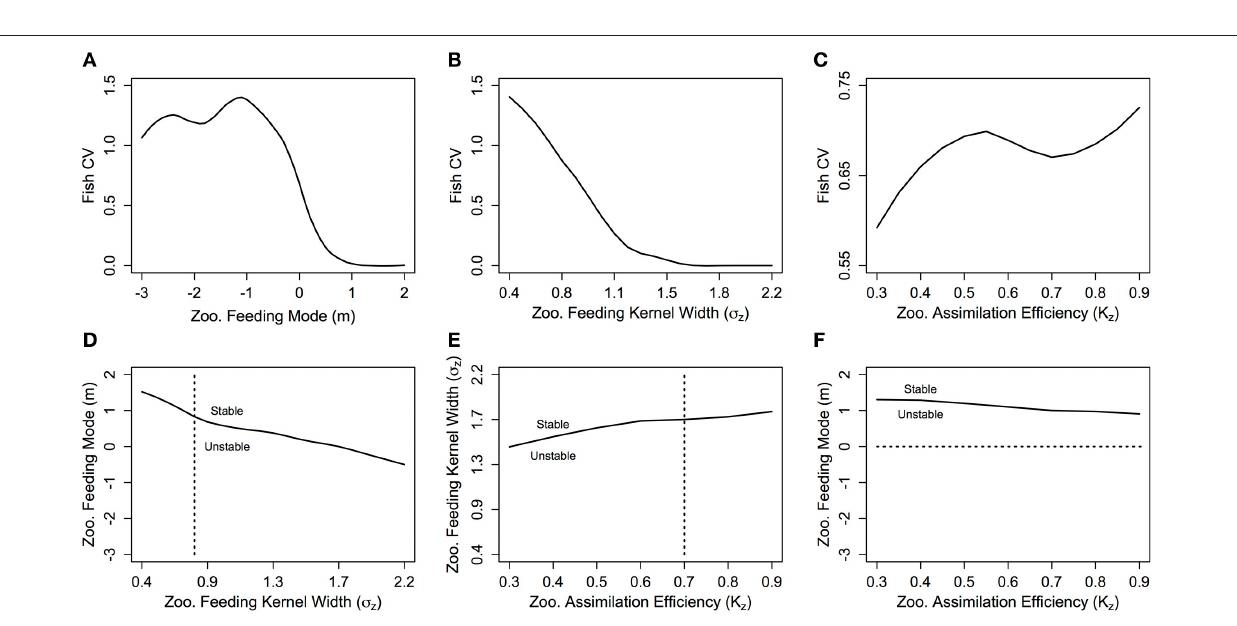
FIGURE 5 | The fish community biomass coefficient of variation (CV) against zooplankton (A) feeding mode ( m ), (B) feeding kernel width ( σ z ) and (C) assimilation efficiency ( K z ), and the stability regions of (D) m against σ z , (E) σ z against K z and (F) m against K z . In (D–F) the dashed lines indicate the transect over which the CV in the plot above is taken. In each plot, the other feeding parameters not specified are held constant at m